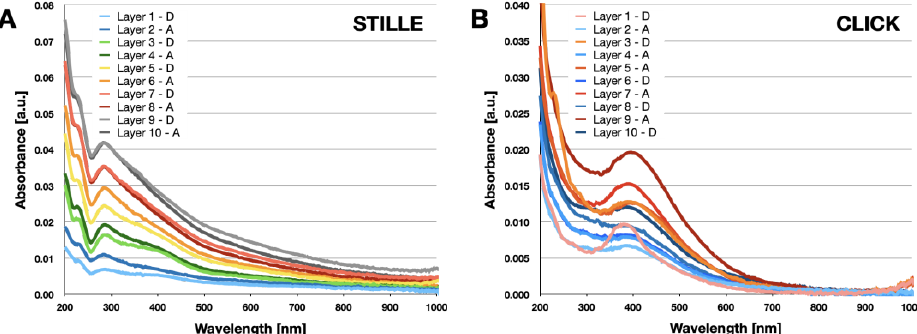
Figure 4. UV-Vis spectra of polymer layer obtained on quartz substrate via: ( A ), Stille coupling, ( B ), Click reaction.